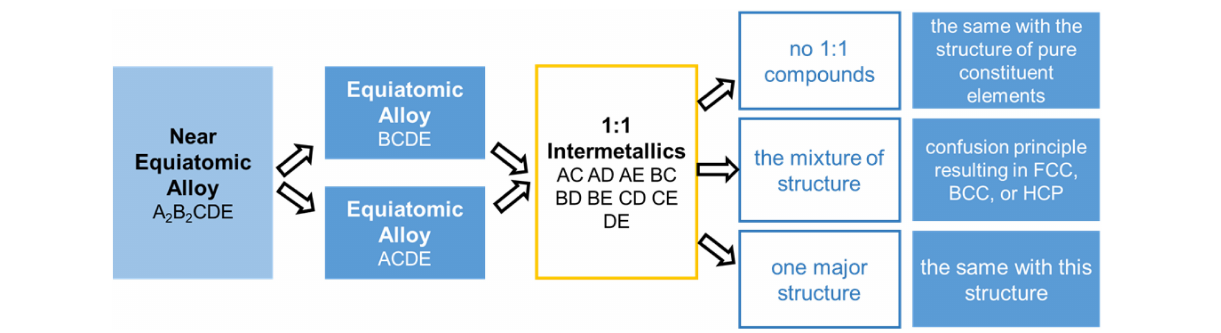
FIGURE 1 | Equiatomic or near-equiatomic HEAs phase selection using the Pettifor